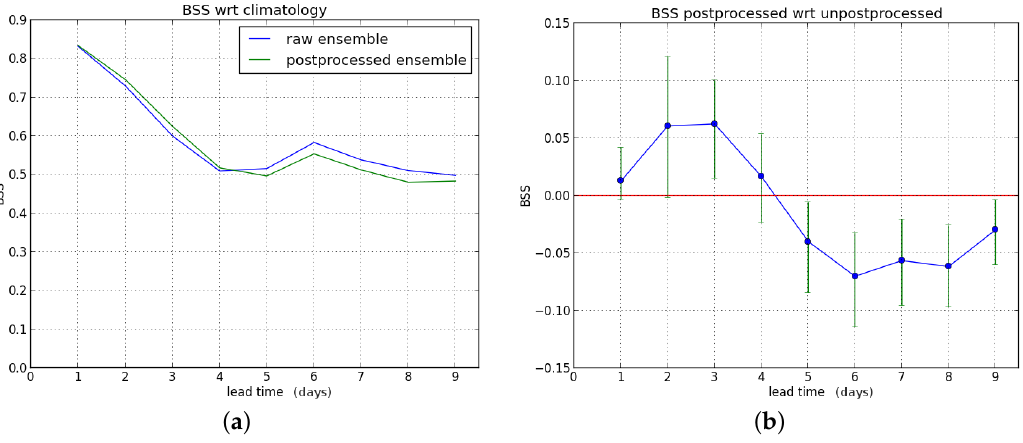
Figure 8. Brier Skill Score for the P90 threshold. Comparison with reference discharge, hydrological winter. ( a ) Compared to sample climatology; ( b ) Improvement due to